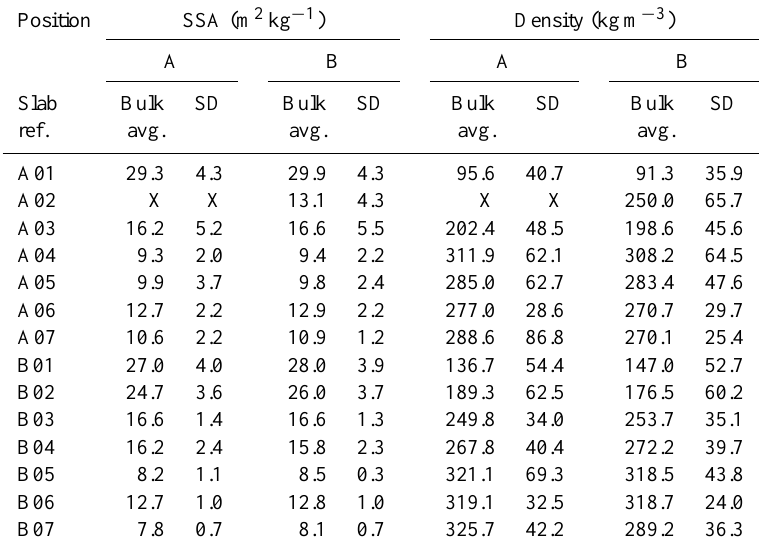
Table 4. Micro-CT-derived bulk average and standard deviation values of SSA and density. The values for A and B correspond to positions A and B in Fig. 3. Micro-CT A02A was not analysed, thus values of SSA and density are not given.